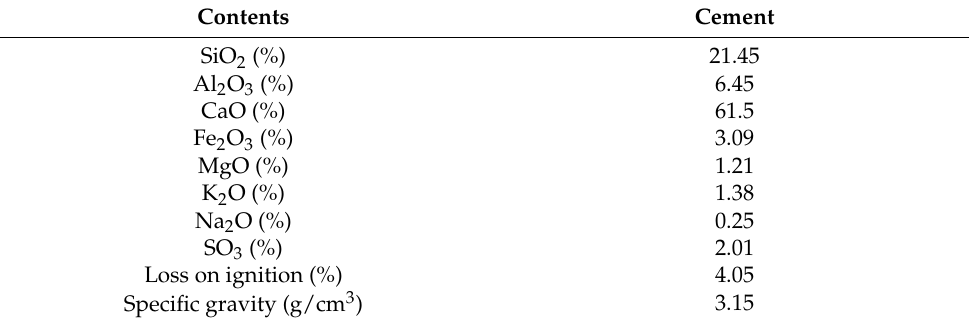
Table 2. Properties of aggregates. Table 1. Chemical composition of the cement.